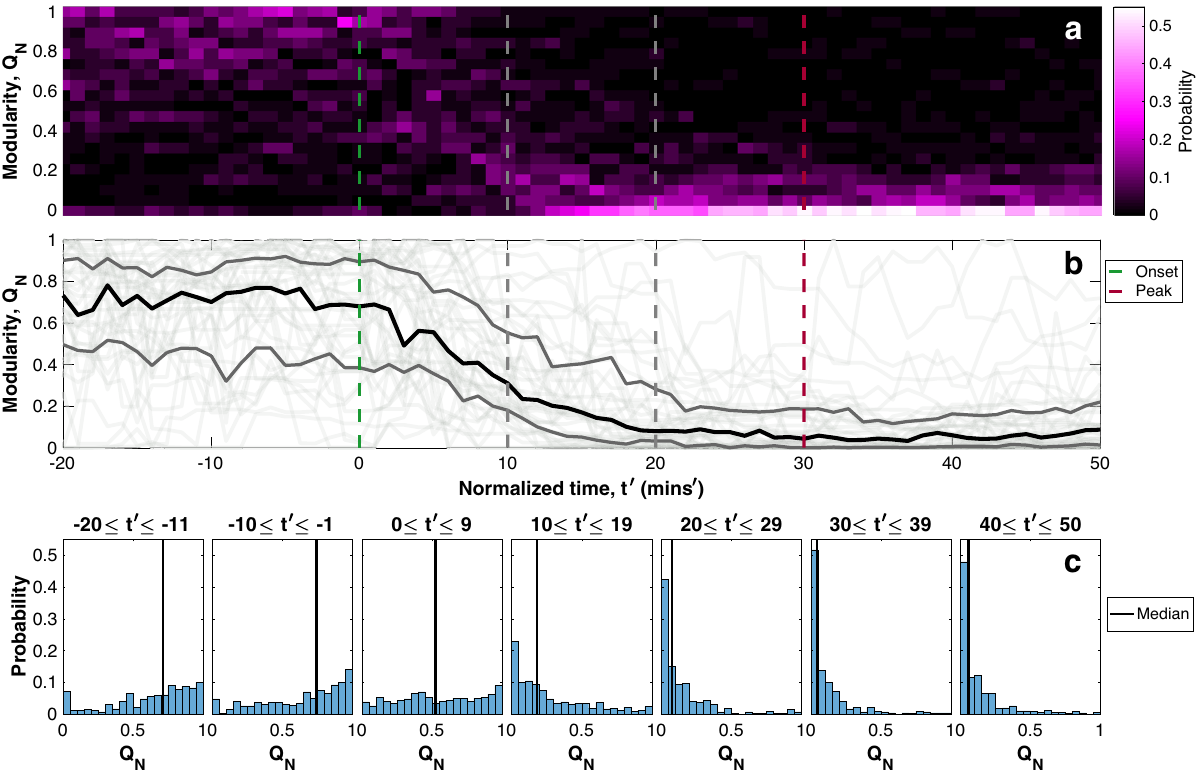
Fig. 3 Community structure of multiple substorm events. The normalized modularity, Q N , of the set of 41 substorms that have two or more magnetometers in four even local time sectors of the nightside and are quiet before onset. a, b Share normalized time as the abscissa. a Ordinate bins Q N at each normalized time and the color indicates the probability (count of substorms with Q N /total number of substorms). b Plots Q N of each of the 41 substorms as a function of normalized time, t 0 , as thin light gray lines. The median is overplotted in black and the 25 and 75% quantiles in darker gray. c Plots the normalized histograms of Q N of the events aggregated over 10-min intervals as time progresses. The median is